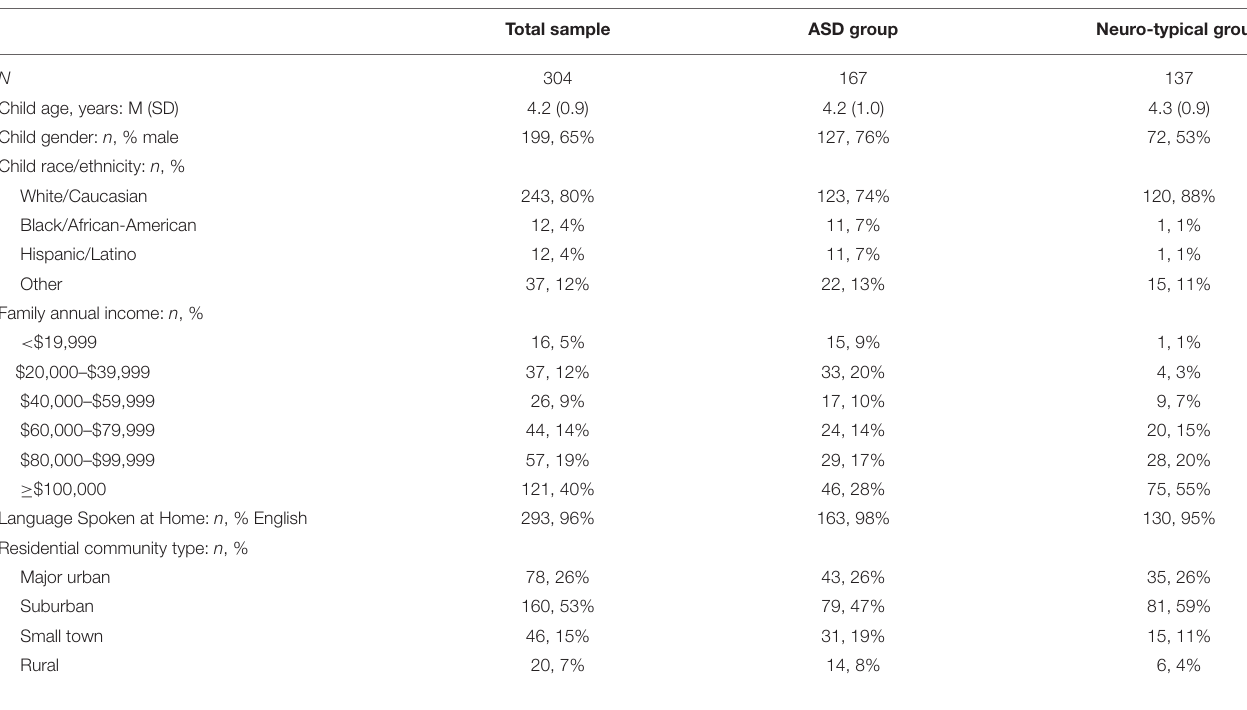
TABLE 1 | Child and family